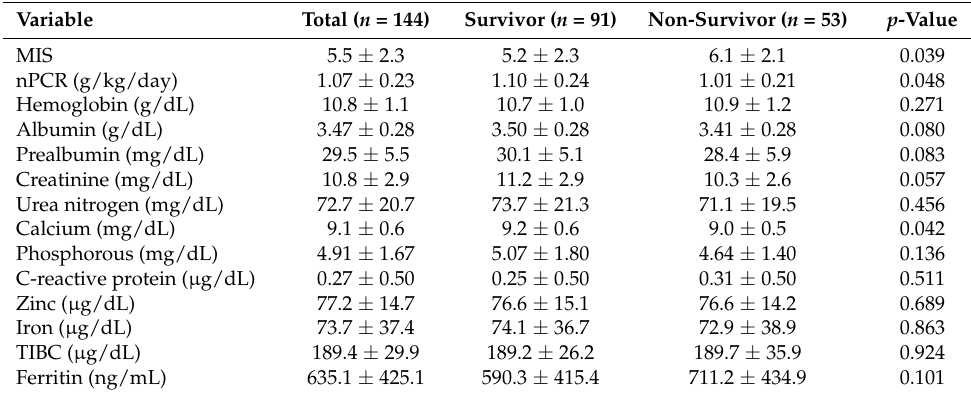
Table 3. Comparisons of malnutrition inflammation score (MIS) and laboratory variables in end-stage renal disease patients on maintenance hemodialysis. Variable MIS